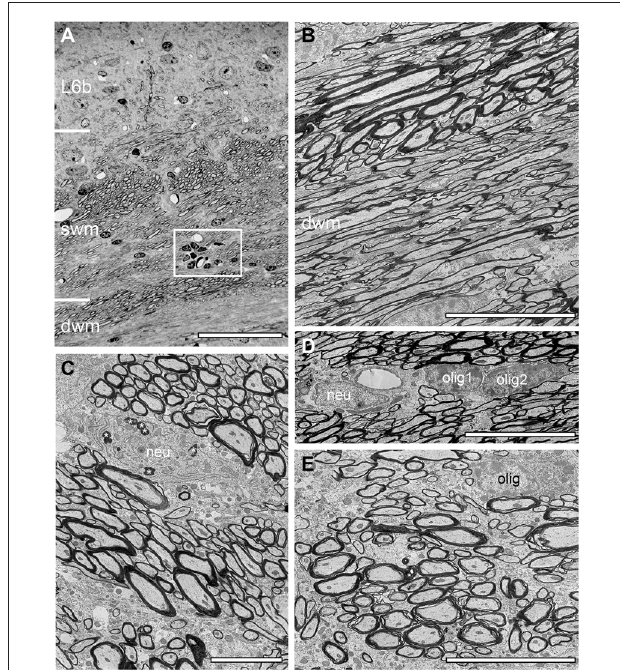
FIGURE 4 | Structural composition of the white matter in WT mouse neocortex. (A) Semithin section at the L6/white matter border. Note the abrupt loss of neurons at the L6/white matter border, the different orientation of axonal fiber bundles in the superficial (swm), deep white matter (dwm) and the occurrence of a cluster of oligodendrocytes (framed area). Scale bar 50 µ m. (B) EM micrograph showing part of the dwm with axonal fibers of different orientation, shape and size. Scale bar 10 µ m. (C) EM micrograph through the swm showing individual fascicles with the same fiber orientation. Occasionally also neurons (neu) were found within such fascicles, some of which contained lipofuscin granula (asterisks). Scale bar 5 µ m. (D) Heterogeneous group of two oligodendrocytes (olig1, olig2) and a neuron (neu) in dwm. Scale bar 5 µ m. (E) High-power EM micrograph of an individual axonal fascicle in the swm with a neighboring oligodendrocyte (olig). Scale bar 5 µ m.